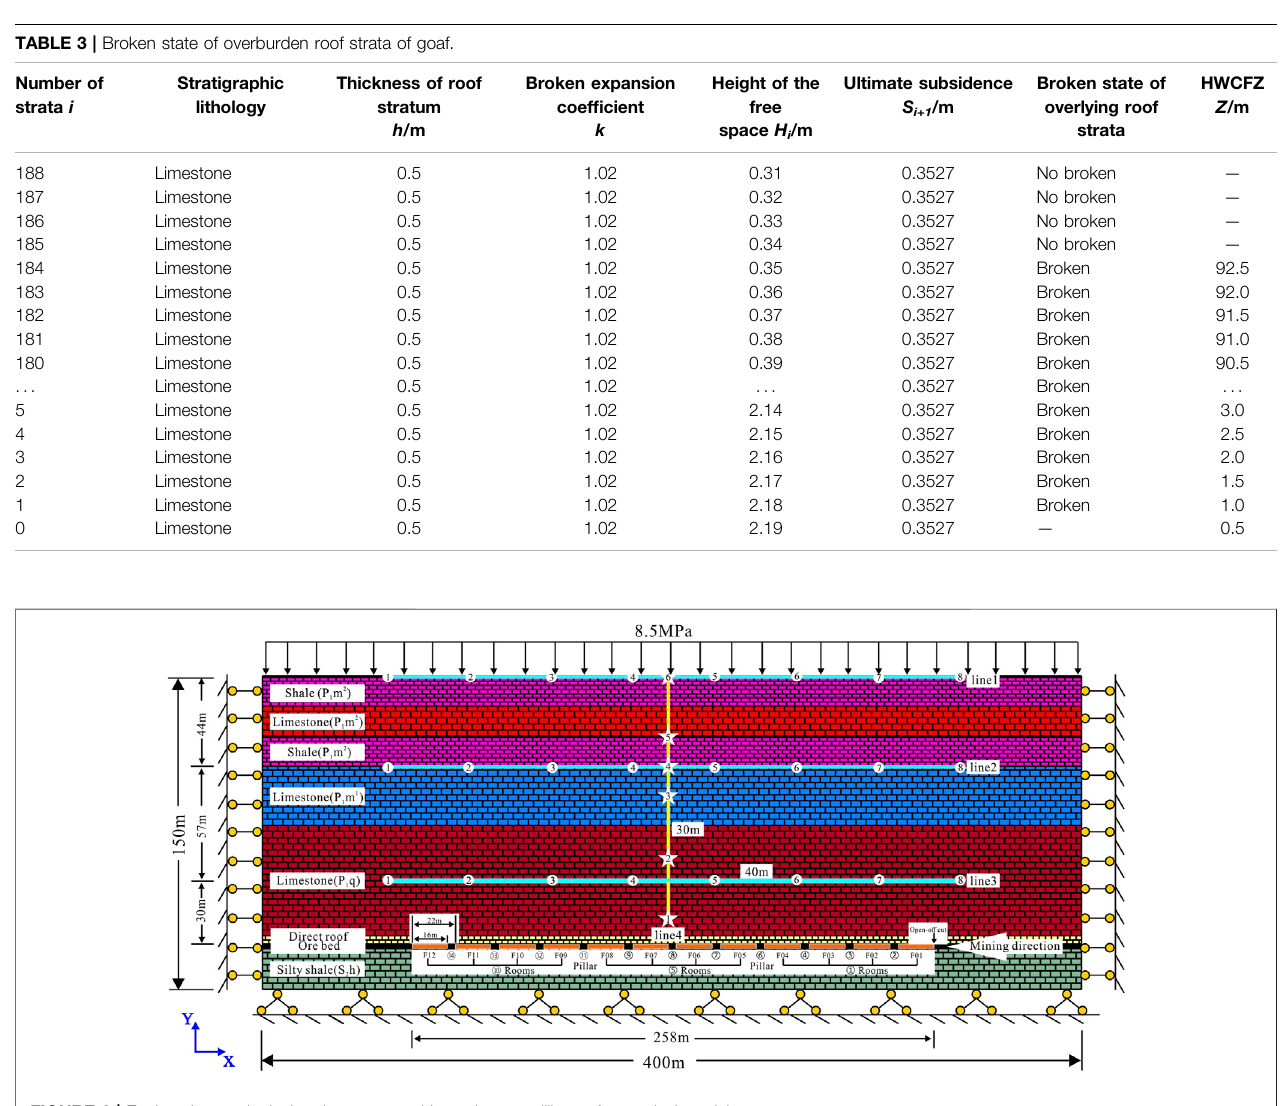
FIGURE 6 | Engineering geological rock groups and boundary condilions of numerical model.